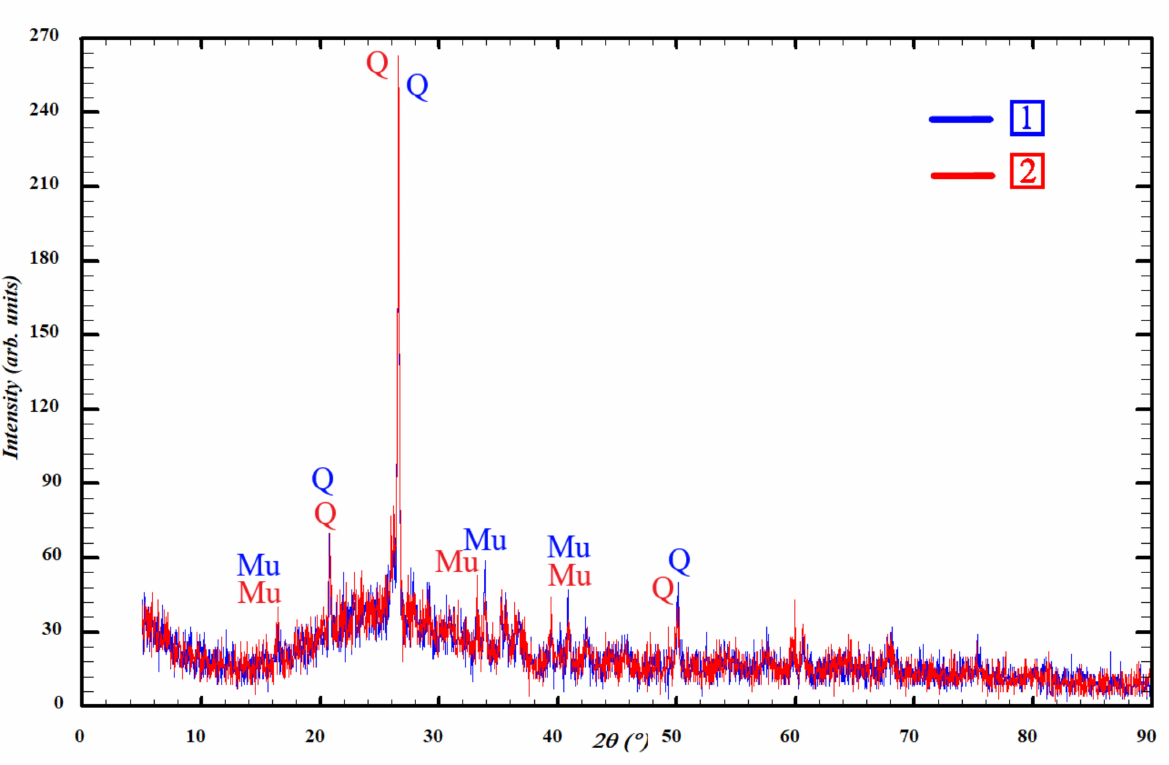
Figure 6. X-ray diffraction pattern of porous geopolymers based on the Apatitskaya CHPP: 1—“Ag” Composition, 2—“As” Composition; Q—high quartz,